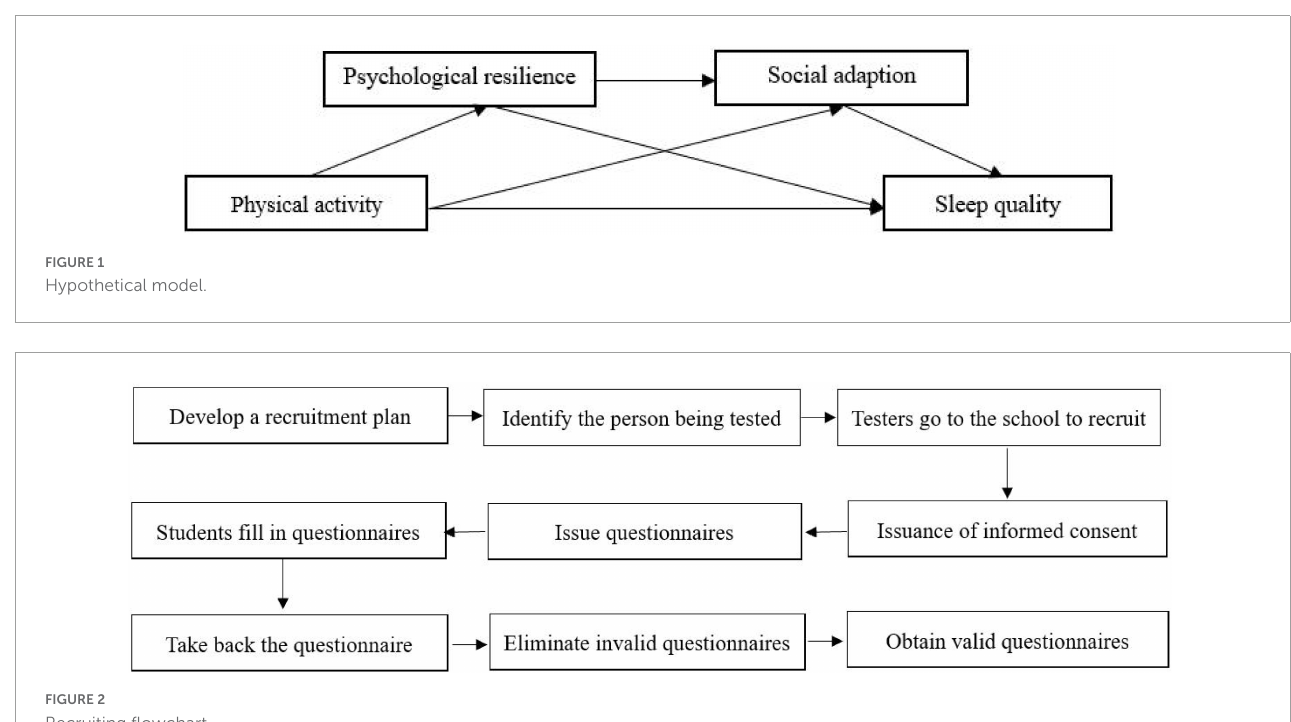
FIGURE2 Recruiting